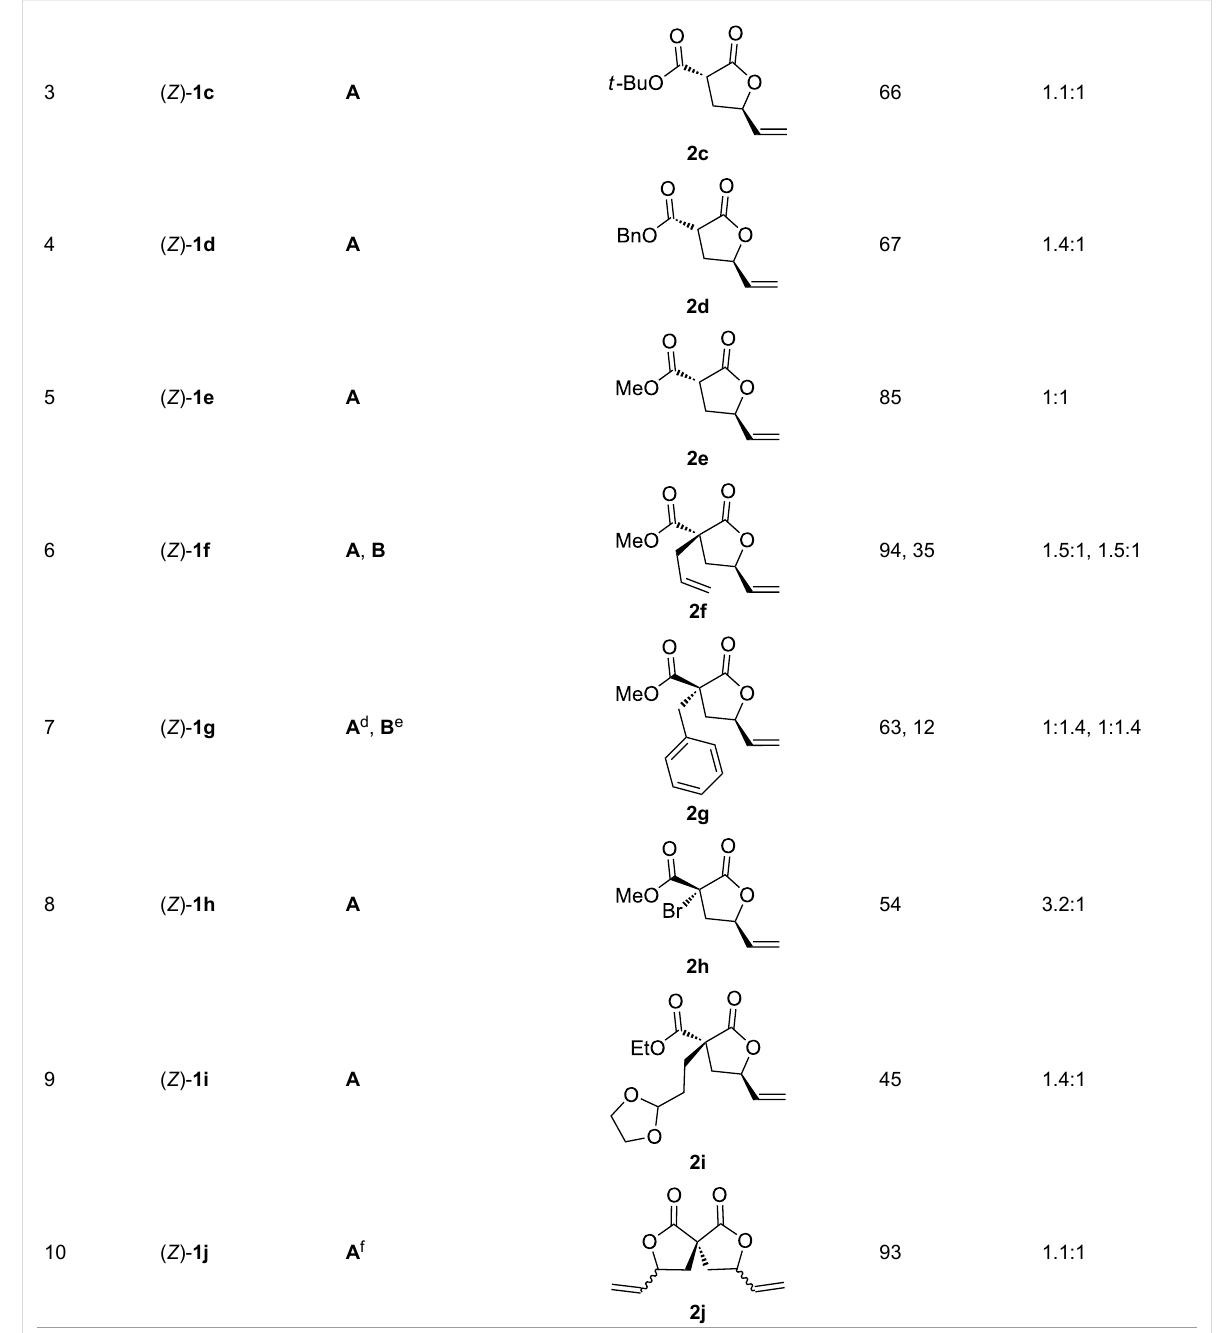
Table 2: Proving the scope of the gold-catalyzed intramolecular allylation of 1 . a